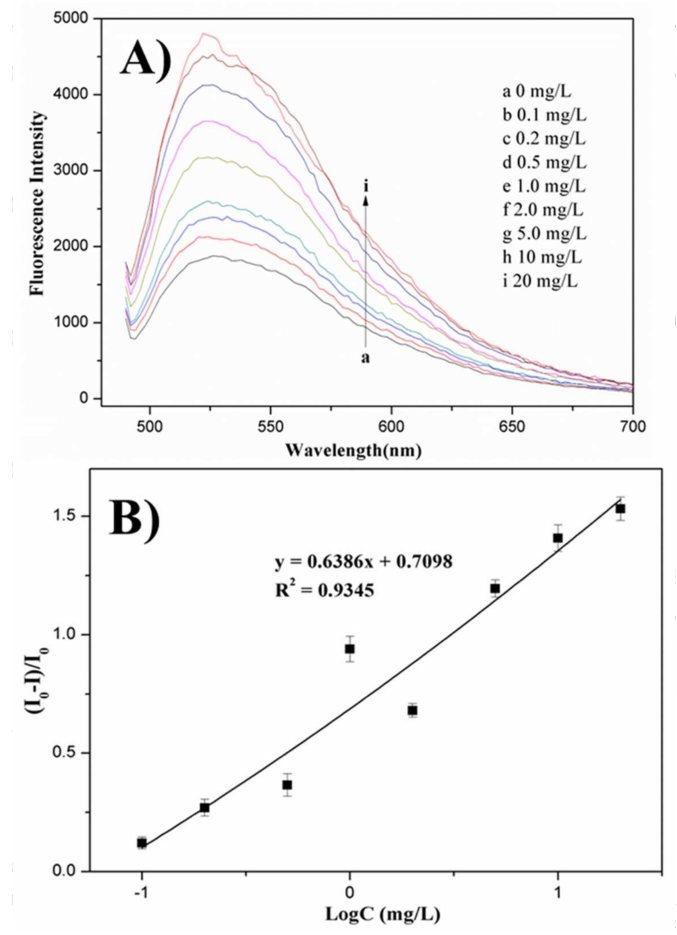
Figure 5. ( A ) Fluorescence spectra of FITC-Mel with different concentrations of melamine and ( B ) Standard calibration plots of ( I – I 0 )/ I 0 against the logarithm of the melamine concentration from 0.1 to 20 mg/L in milk